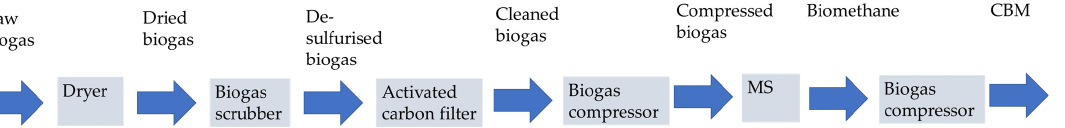
Figure 10. MS biogas-to-biomethane upgrading pathway. In addition to MS technology, a scrubber and a drier have been added to remove moisture and H 2 S. The activated carbon filter has also been added to remove traces of H 2 S and volatile organic compounds (VOCs). A compressor is prelimi- narily added for compressed biomethane.